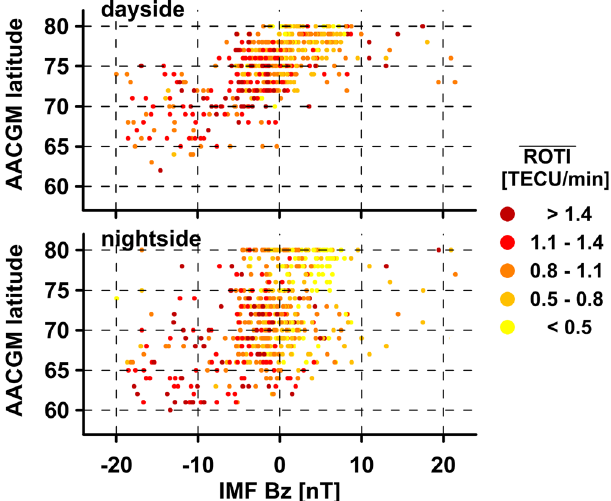
Fig. 14. The position of the maximal TEC fl uctuation as a function of IMF